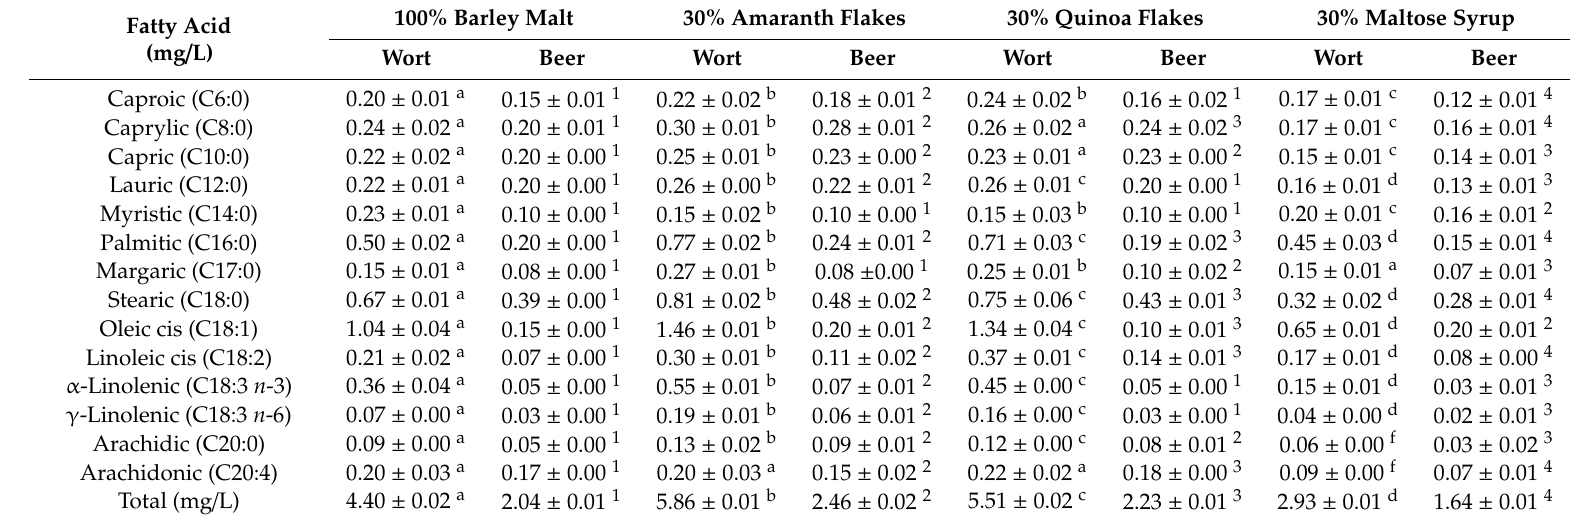
Table 1. The fatty acid profile in wort and beer produced only from barley malt and with addition of unmalted pseudocereals or